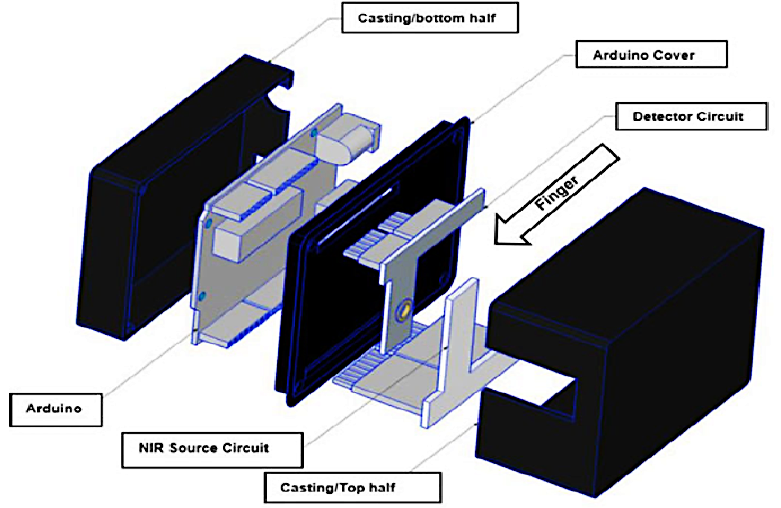
Figure 8. 3D view of the non-invasive glucose monitoring system, proposed in [33], with the main components highlighted.